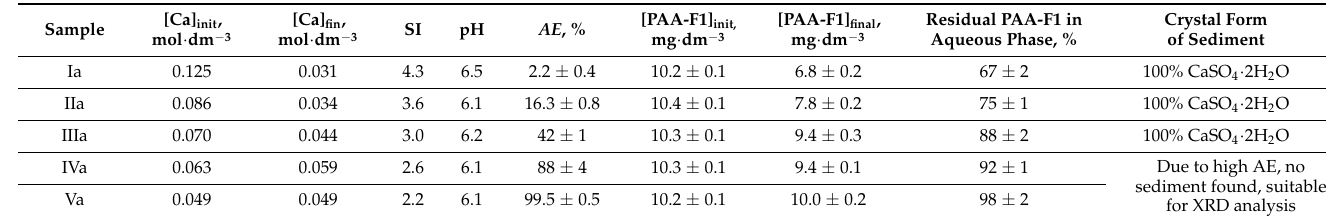
Table 2. Results of experiments, performed in the in presence of 10 mg · dm − 3 PAA-F1.